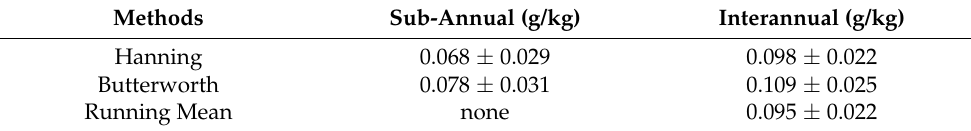
Table 2. The STDs of SSS on different time scales using different methods averaged over the globe.